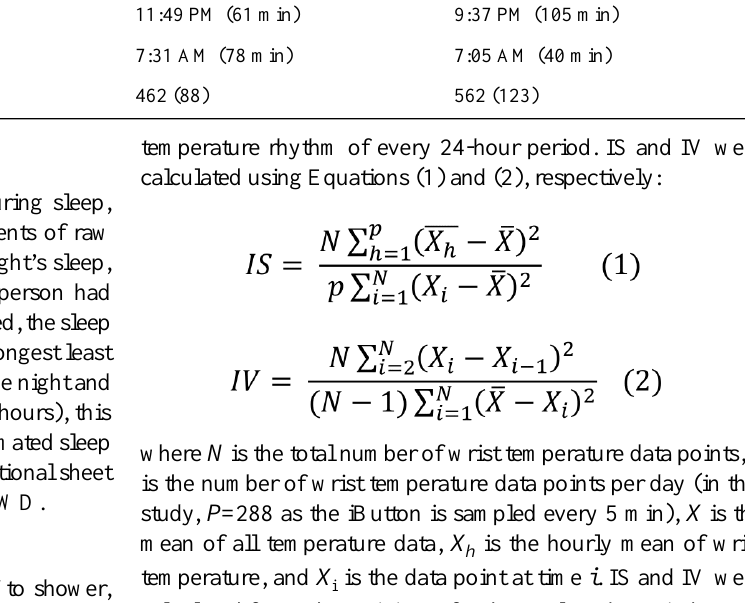
Older adults living with dementiaOlder adultsYounger adultsSleep